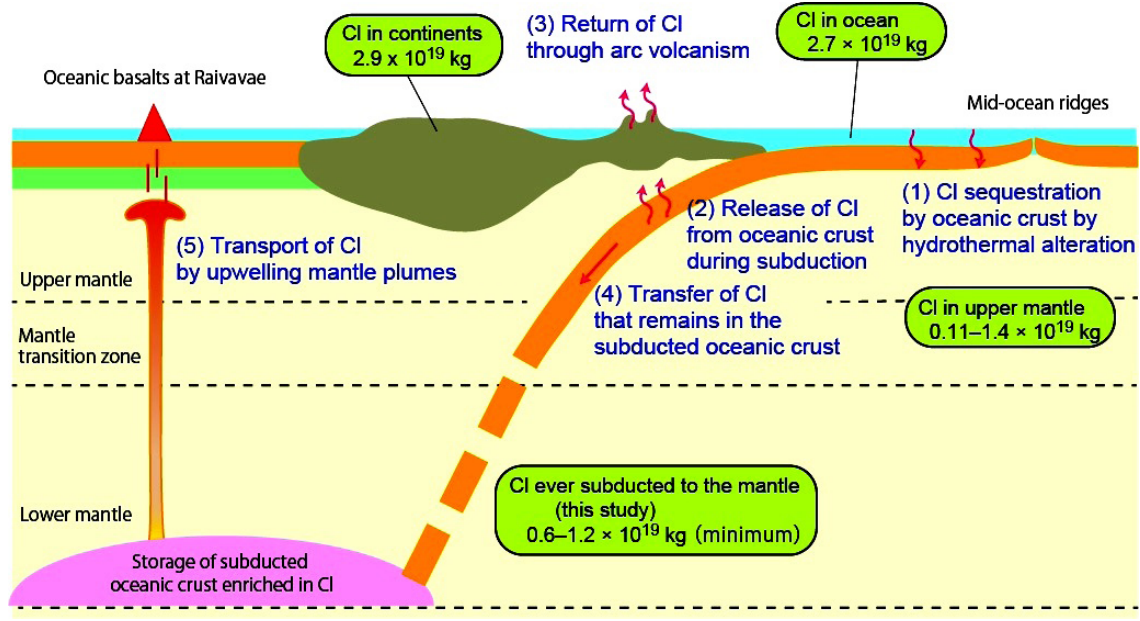
Figure 2: The Cl cycling from the oceanic crust to the surface, through the mantle. (1) The oceanic crust takes Cl from the seawater. (2) Cl is lost from the subducted oceanic crust under high temperature and pressure conditions. (3) Cl is returned to the surface through arc volca- nism. (4) Small amounts of Cl remain and sink to form a Cl-rich reservoir in the lower mantle. (5) Cl-rich mantle material is transported by the upwelling of mantle plumes, generating Cl-rich ocean island basalts. Green ovals show the Cl in major Cl reservoirs. The minimum estimated Cl transported by subducted oceanic crust (0.6–1.2×10 19 kg) is comparable to the Cl in the upper mantle. After Hanyu et al. (2019). Reprodu- ced with Author’s